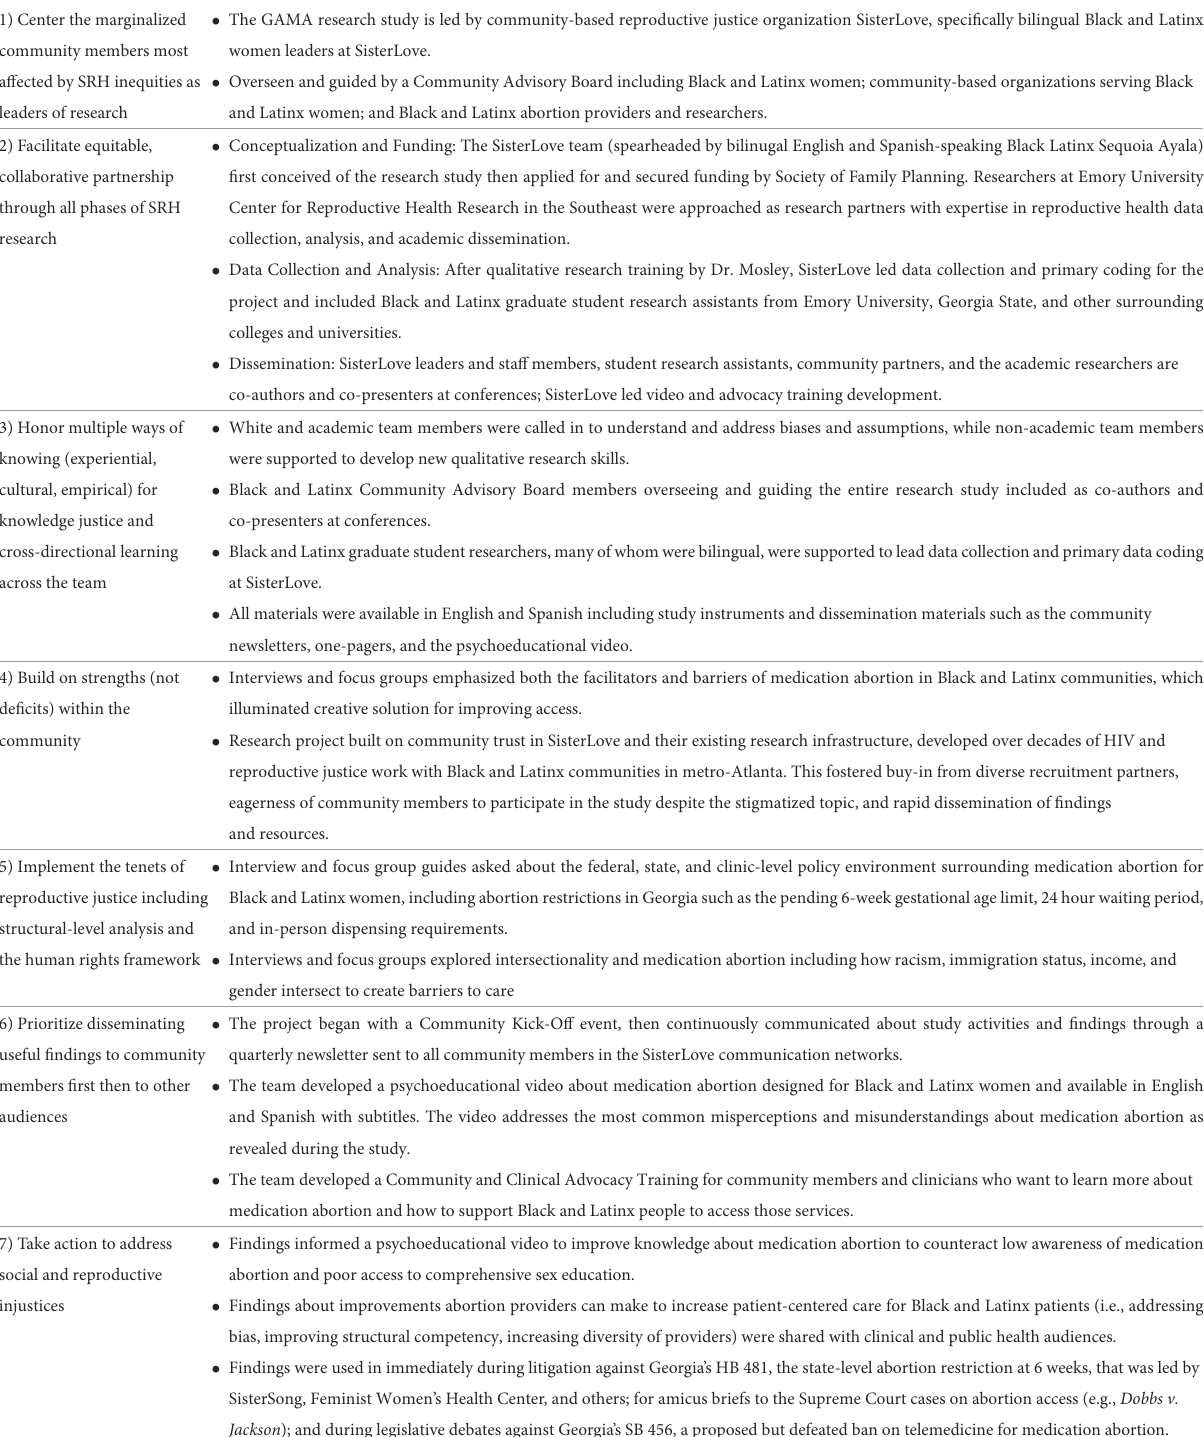
TABLE 1 Principles of community-led research for reproductive justice in the SisterLove Georgia medication abortion project. Principle of Example from the SisterLove Georgia Medication Abortion community-led research for reproductive justice